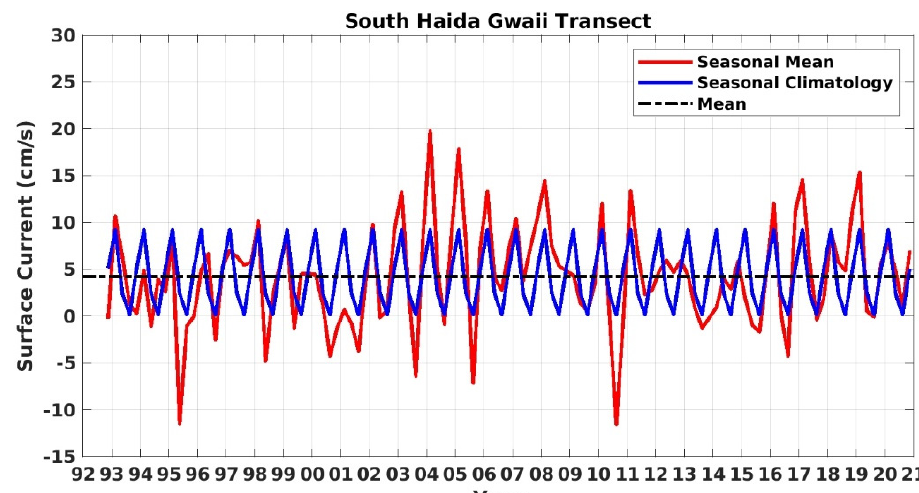
Figure 6. Same as Figure 3 but at the South Haida Gwaii Transect.